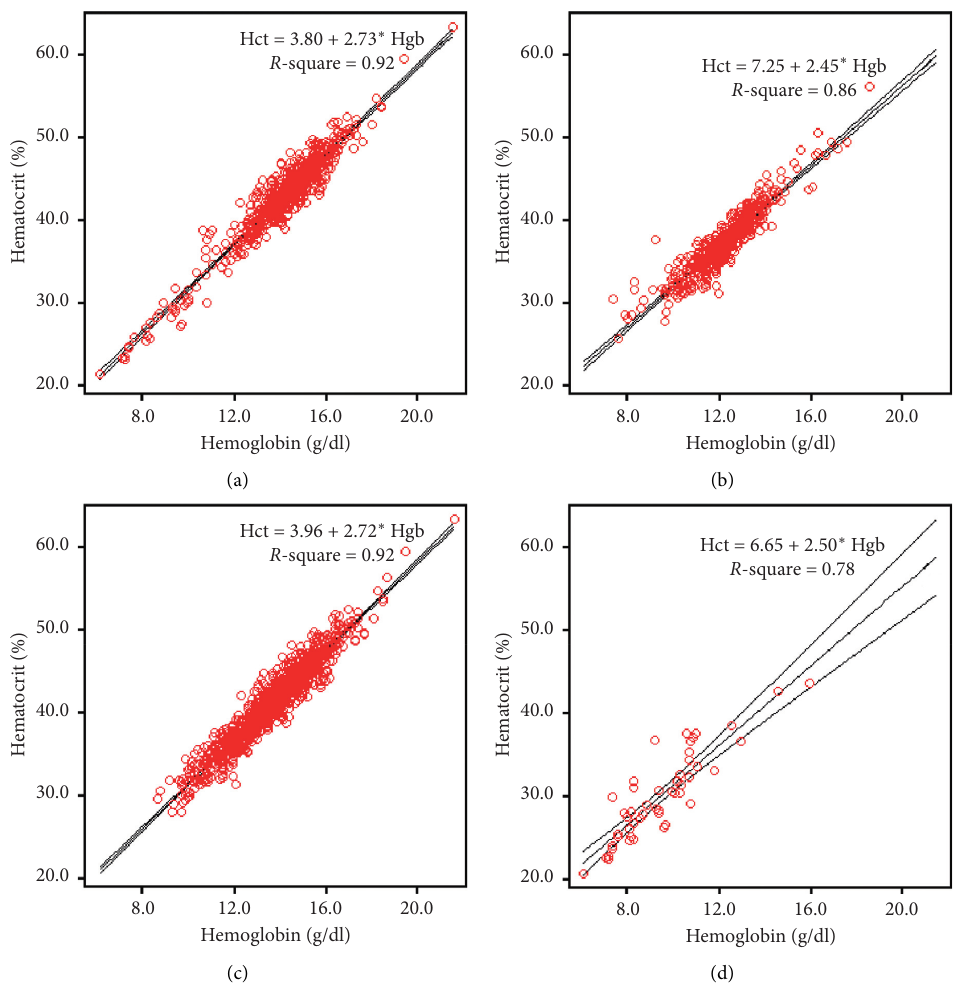
Figure 3: Paired hematocrit and hemoglobin of dengue patients by sex and red cell distribution width (RDW). Scatter plots of the (a) 654 paired measurements of hematocrit and hemoglobin from 88 men with the line of best fit; (b) 487 paired measurements of hematocrit and hemoglobin from 75 women with the line of best fit; (c) 1,092 paired measurements of hematocrit and hemoglobin from patients who had RDW ≤ 18 with the line of best fit; (d) 49 paired measurements of hematocrit and hemoglobin from patients who had RDW > 18 with the line of best